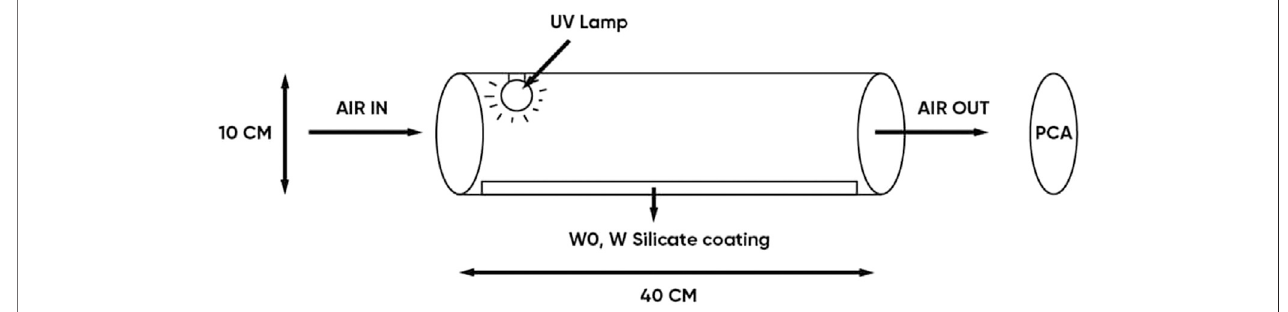
FIGURE 2 | Schematic diagram of the antibacterial experimental of the WO and W silicate